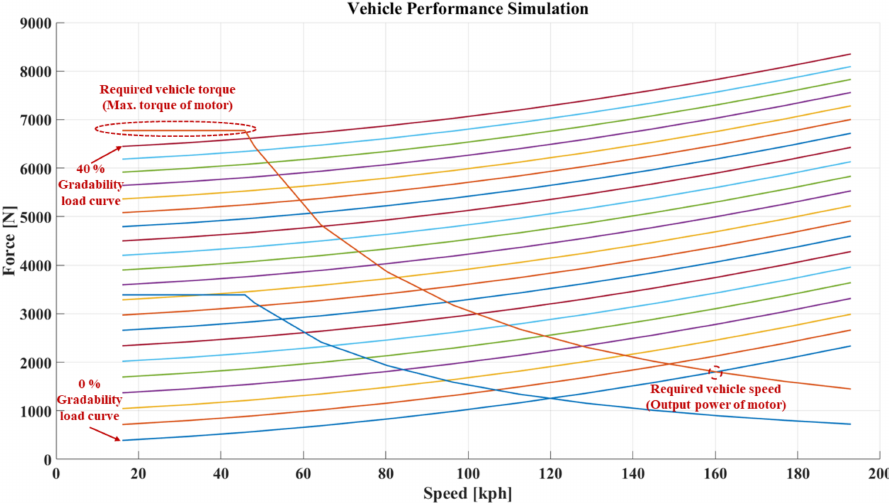
Figure 8. Vehicle driving performance